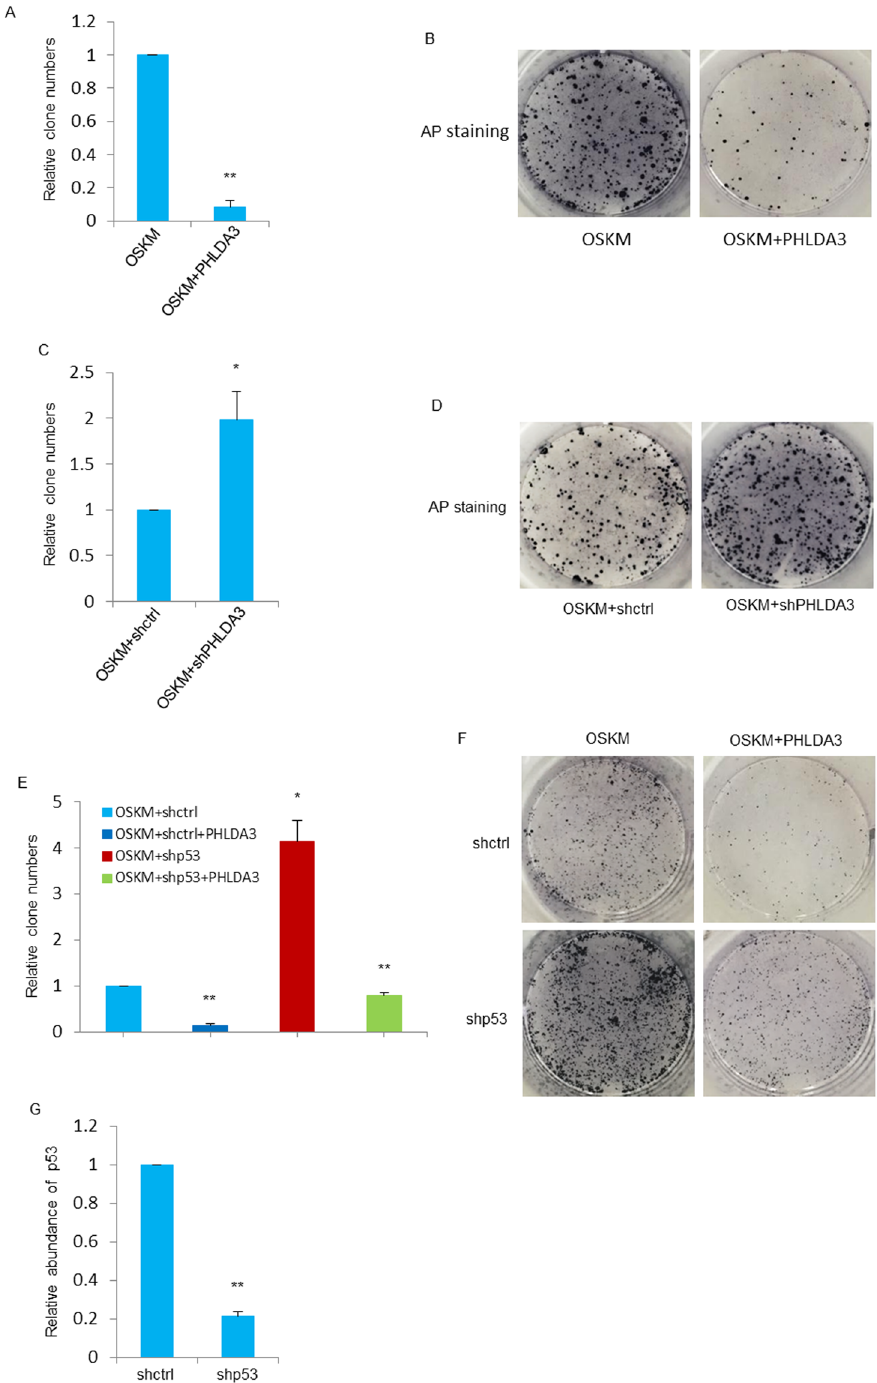
Figure 2. PHLDA3 impedes iPSCs generation. ( A , B ) MEF cells expressing OSKM were infected with either pMXs-ctrl or pMXs-PHLDA3 for 2 days and cultured in fresh DMEM for 4 days. GFP positive iPS clones were calculated under fluorescent microscope ( A ). 10 days after infection, iPS clones were transferred onto new feeder cells and maintained in ES medium for another 5 days, then iPS clones were subjected to Alkaline Phosphatase (AP) staining ( B ). ( C , D ) MEF cells were infected with OSKM plus either control shRNA or PHLDA3 shRNA and maintained as described in Fig. 2A, iPS clones were counted ( C ) and subjected to AP staining ( D ). ( E , F ) MEF cells expressing OSKM were infected with pMXs-PHLDA3, shRNA against p53 or pMXs-PHLDA3 plus shRNA against p53 as indicated. GFP positive iPS clones were calculated ( E ) and subjected to AP staining ( F ). ( G ) p53 knock-down efficiency was evaluated by qRT-PCR